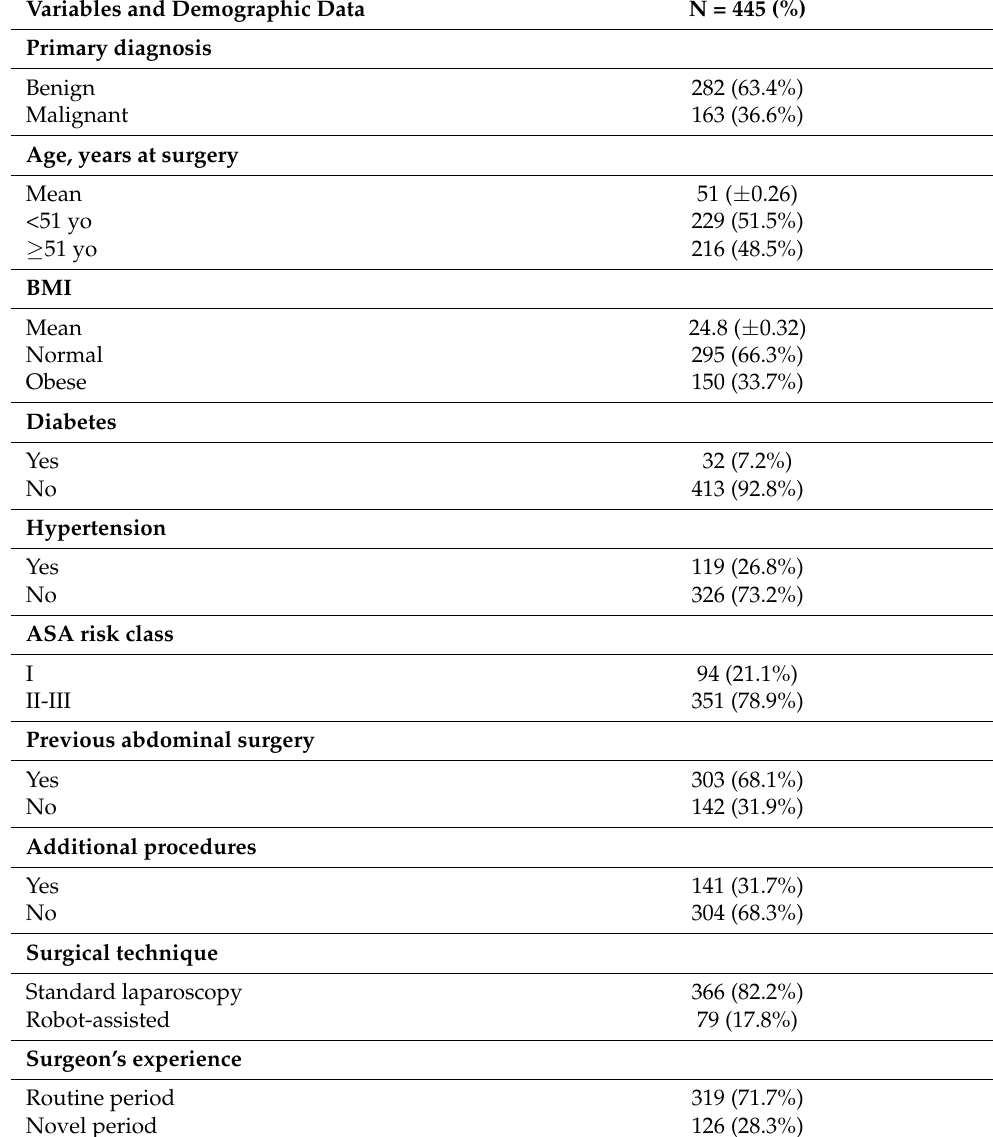
Table 1. Baseline characteristics of the study